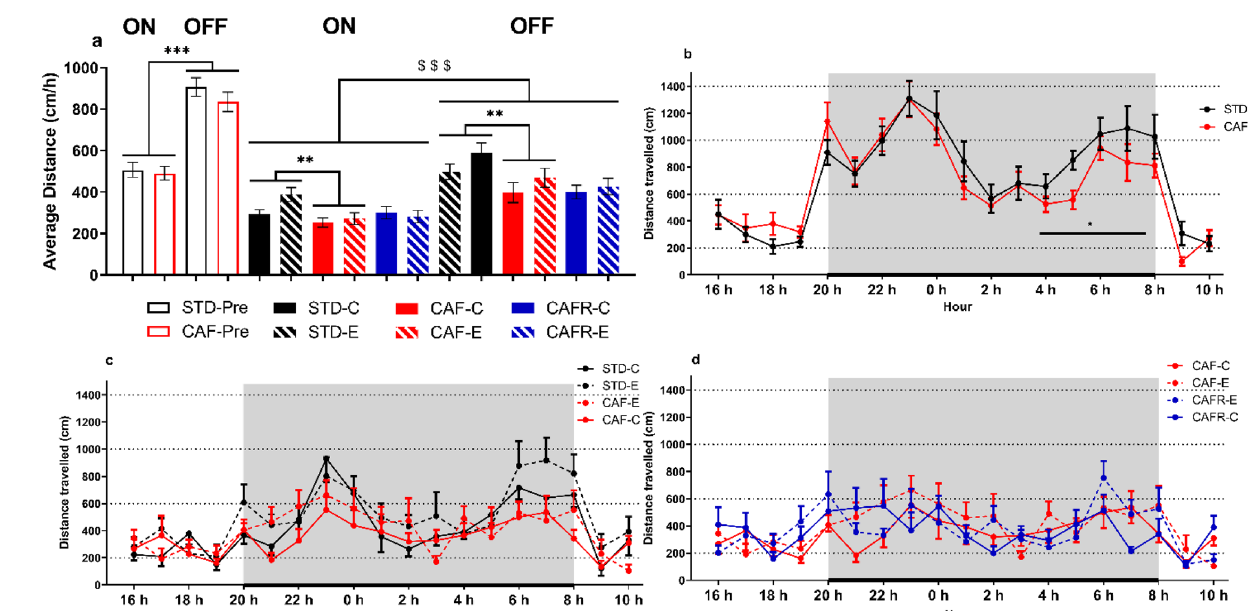
Figure 3. Effects of dietary interventions and exercise on circadian activity. Two Home-Cage Activity tests were performed at week 9 and week 17. ( a ) Average hourly distance traveled (cm) for the ON and OFF periods in both time points (week 9, -Pre, and week 17). ( b ) Hourly distance traveled (cm) for the ON and OFF (grey square area) periods at week 9. ( c ) Hourly distance traveled (cm) for the STD and CAF, control and exercised, groups at week 17. ( d ) Hourly distance traveled (cm) for the CAF and CAFR, control and exercised, groups at week 17. Values are mean ± SEM. $$$ p < 0.001 versus ON period, * p < 0.05 versus STD. ** p < 0.01 versus CAF and CAFR feeding decreased, and exercise marginally increased circadian locomotor activity. To determine whether obesity affected circadian locomotor activity, we performed the HCA test at weeks 9–10. We first analysed the average distance travelled over the lights ON and lights OFF periods (Fig. 3A). As expected, average activity in the OFF period was higher than in the ON period [period: F(1,54) = 187.851, p < 0.001], with no interaction with the diet. We then analysed the hourly activity over the OFF and ON periods separately. The activity changed over the OFF period hours (Fig. 3B) [hour: F(11,594) = 8.750, p < 0.001], but no interaction with the diet was found. However, we noticed that the CAF fed animals appeared to decrease their activity during the last 4 h of the OFF period (from 04h until 08h). So, we analysed the total activity of this 4 h-period (Fig. 3B) and found that the CAF animals were less active compared to the STD animals [U = 219; p = 0.016]. Regarding the ON period (Fig. 3B) we found a tendency for activity to change over time [hour: F(5270) = 2.335, p = 0.051], with no effect of diet.